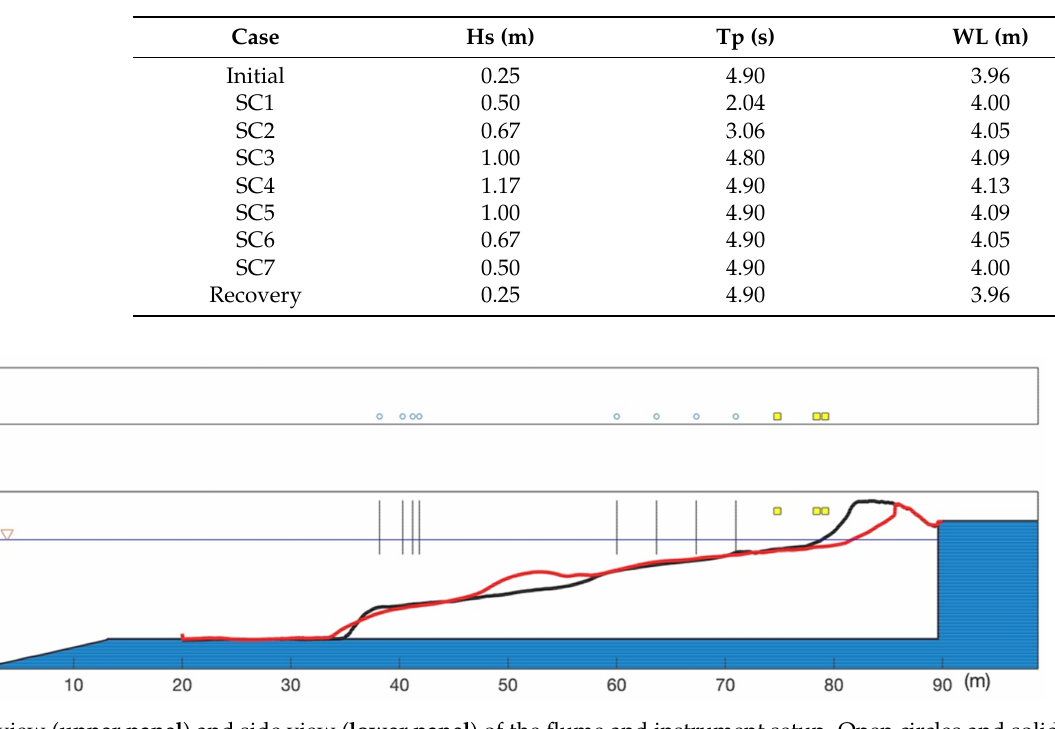
Figure 1. Top view ( upper panel ) and side view ( lower panel ) of the flume and instrument setup. Open circles and solid lines: resistance-type wave gauges; yellow squares: ultrasonic wave gauges; black solid line: initial beach profile; red solid line: final beach